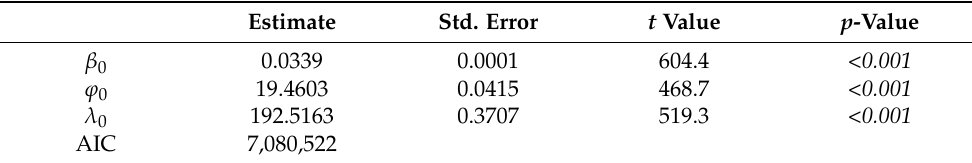
Table 2. SIR Regression estimated by Equation